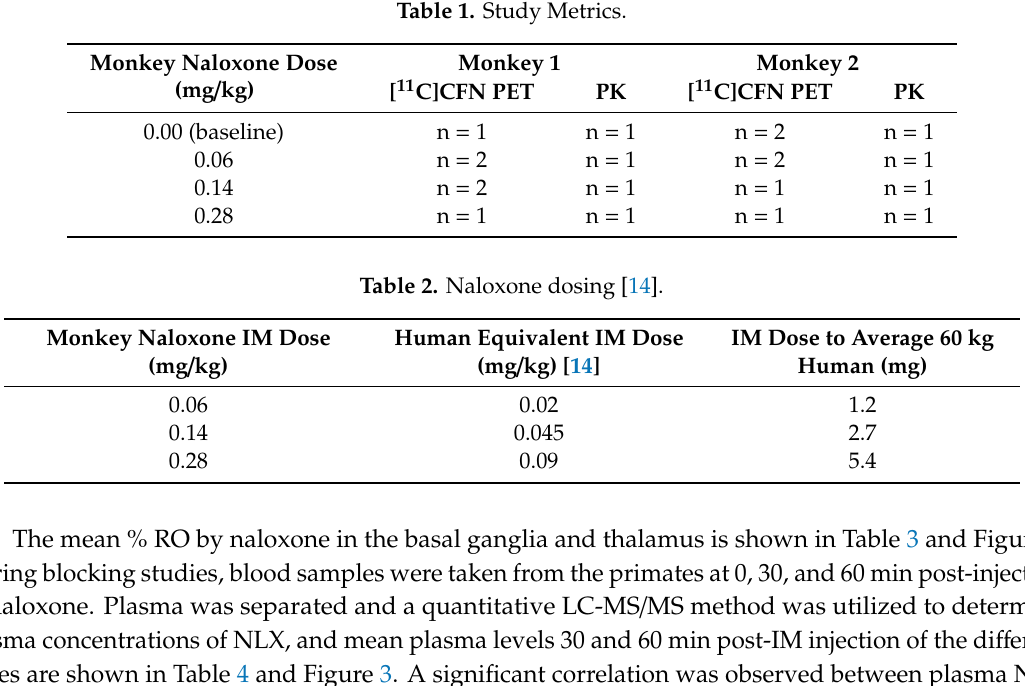
Table 1. Study Metrics.